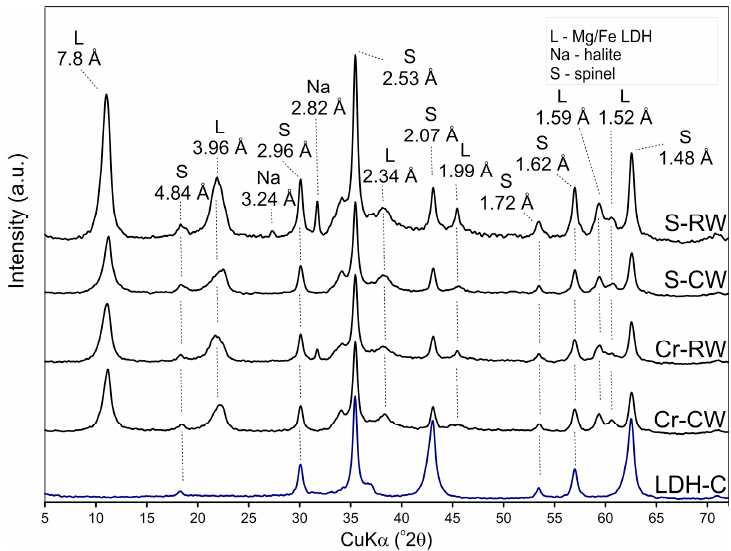
Figure 9. XRD patterns of the LDH-C material after adsorption in multi-element wastewaters.